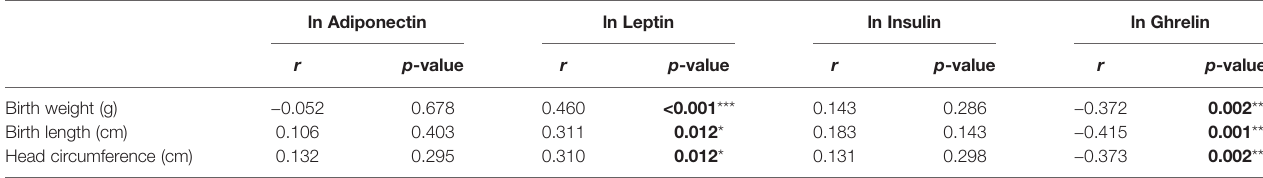
TABLE 4 | Relationship between the levels of adiponectin, leptin, insulin, and ghrelin and the neonatal growth parameters. ln